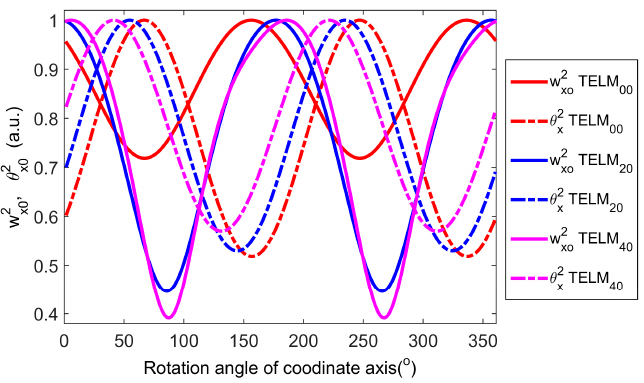
Figure 7. Normalized waist radius w x 0 and divergence half angle θ x in x -directions for Hermite-Gaussian-like modes (TELM 00 , TELM 20 , and TELM 40 ) versus rotation angle of coordinate axis.